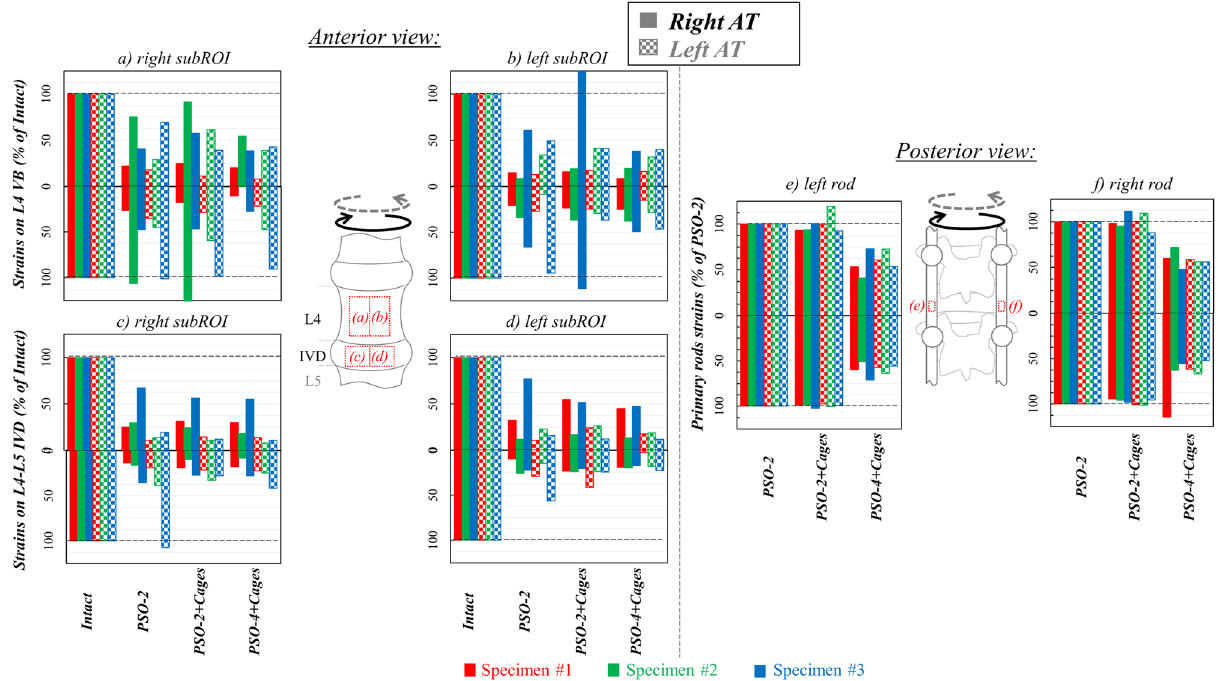
Figure 8. Axial torsion (AT): Normalized strain values on the sub-regions of interest (subROI) on L4 VB ( a : right subROI; b : left subROI) and on the L4–L5 IVD ( c : right subROI; d : left subROI) and normalized primary rods strains both on the left ( e ) and right ( f ) rods following PSO at L4 and posterior instrumentation with 2 primary-rods (“PSO-2”), with 2 rods and supplementary intervertebral cages (“PSO-2 + Cages”), and with supplementary accessory rods and intervertebral cages (“PSO-4 + Cages”). Supplementary Tables provide quantitative strain data either for each specimen and grouped by ipsi-/contra-lateral sides both anteriorly and